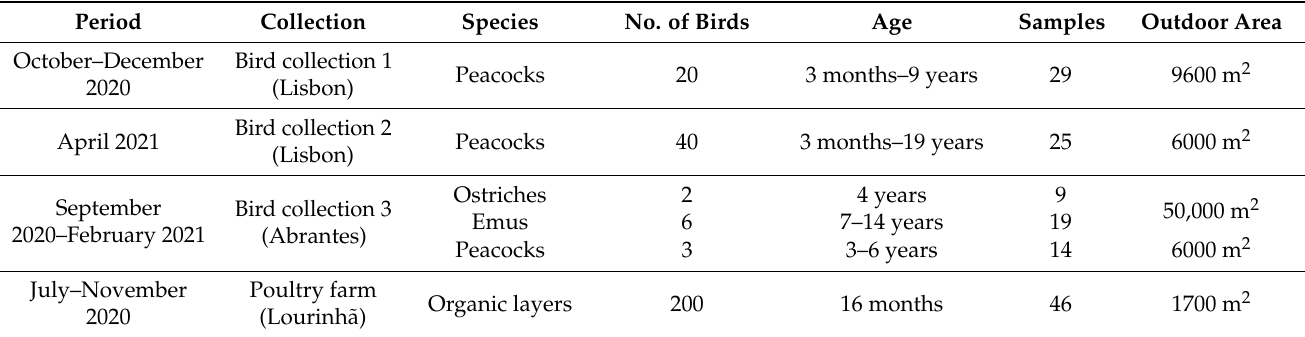
Figure 1. Domestic and exotic birds selected for this study: ( A ) organic layers, ( B ) peacocks, ( C ) ostriches and ( D ) emus (originals). Table 1. Sampling periods, bird species, quantity of samples and outdoor areas.